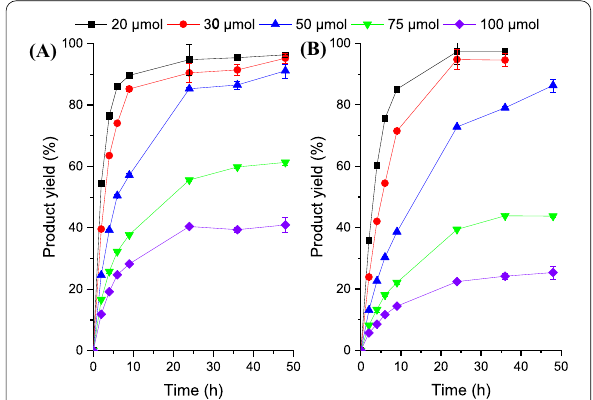
Fig. 3 Effect of the substrate loadings on asymmetric synthesis